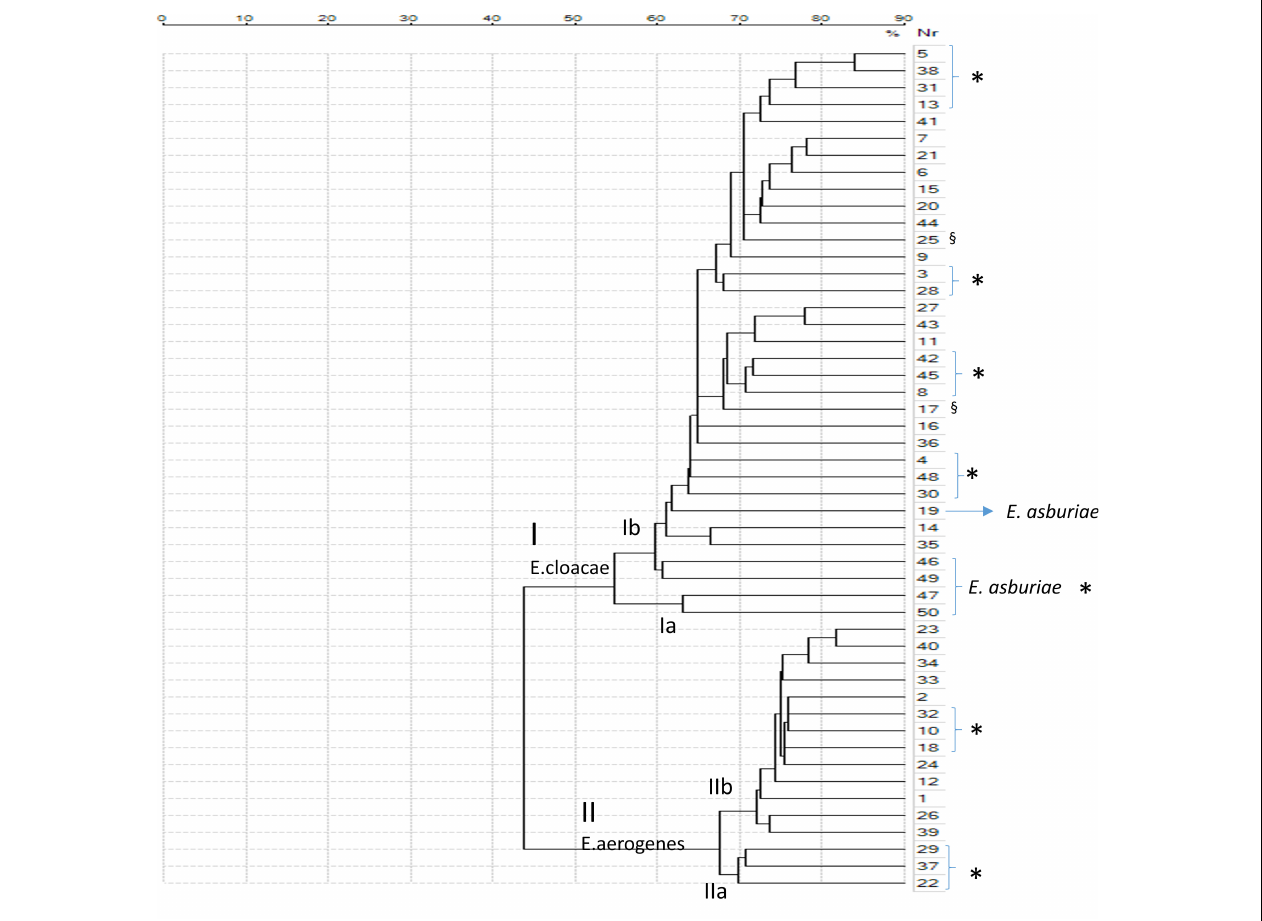
FIGURE 3 | Class dendrogram of all Enterobacter isolates built by the MALDI-TOF VITEK MS Saramis software. Asterisks ( ∗ ) identify strains isolated in general surgery and geriatric wards; the symbol § identify multidrug-resistant (MDR)